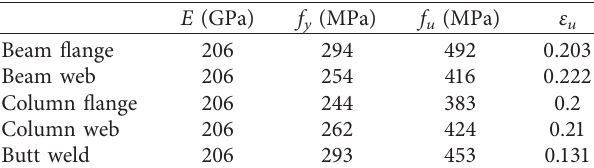
Table 2: Material properties of the beam and column.